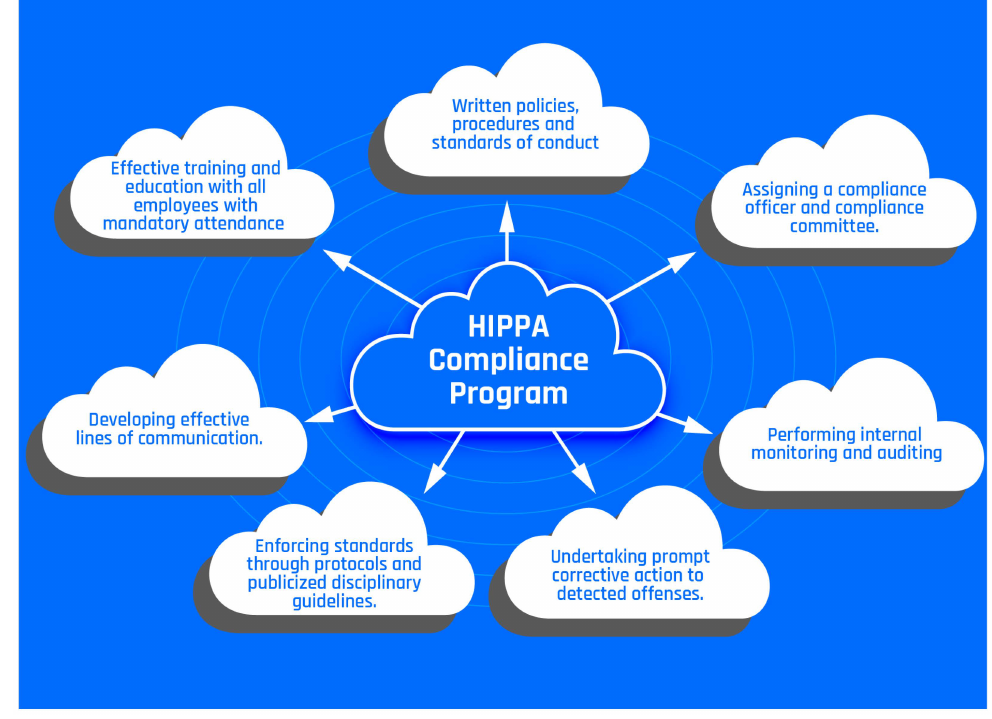
Figure 10. HIPAA compliance program